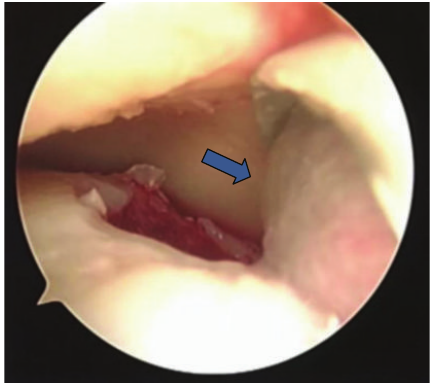
Figure 1: The chondrocytes matrix (arrow) was placed on the cartilage lesion during the 2nd surgical step.